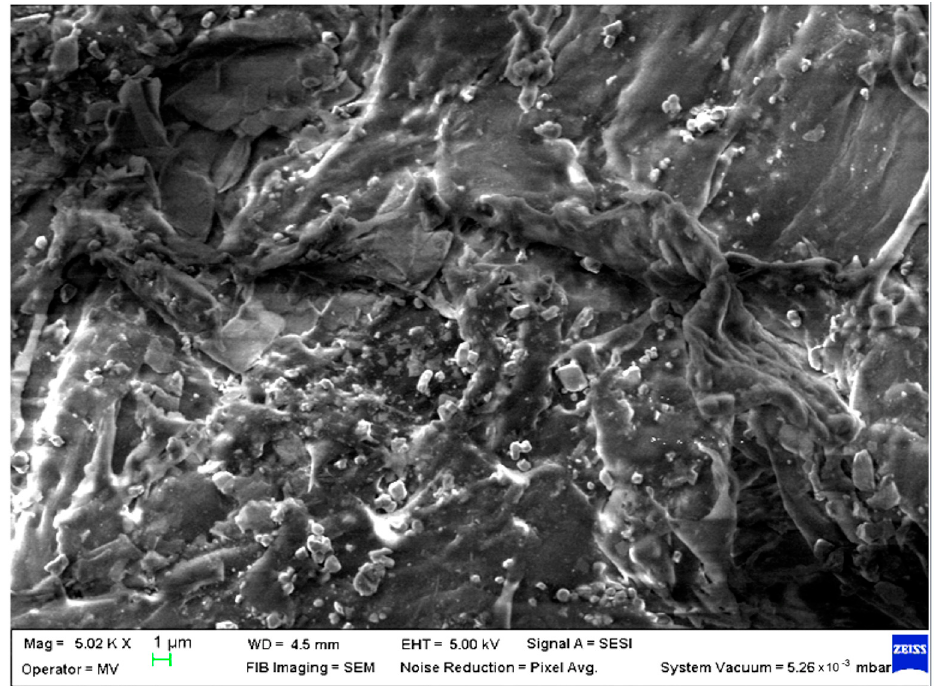
Figure 4. SEM micrographs of PET–Fe composite (M4) sample at T 0 (1 μ m scale).